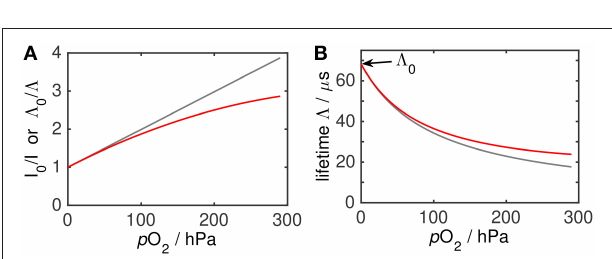
FIGURE 3 | Conceptual illustration of linear Stern-Volmer behavior (gray) and non-linear Stern-Volmer behavior (red) as Stern-Volmer plot (A) and as plot of lifetime 3 against O 2 (B) . Note that the lifetime (or phase shift)—oxygen dependency is always